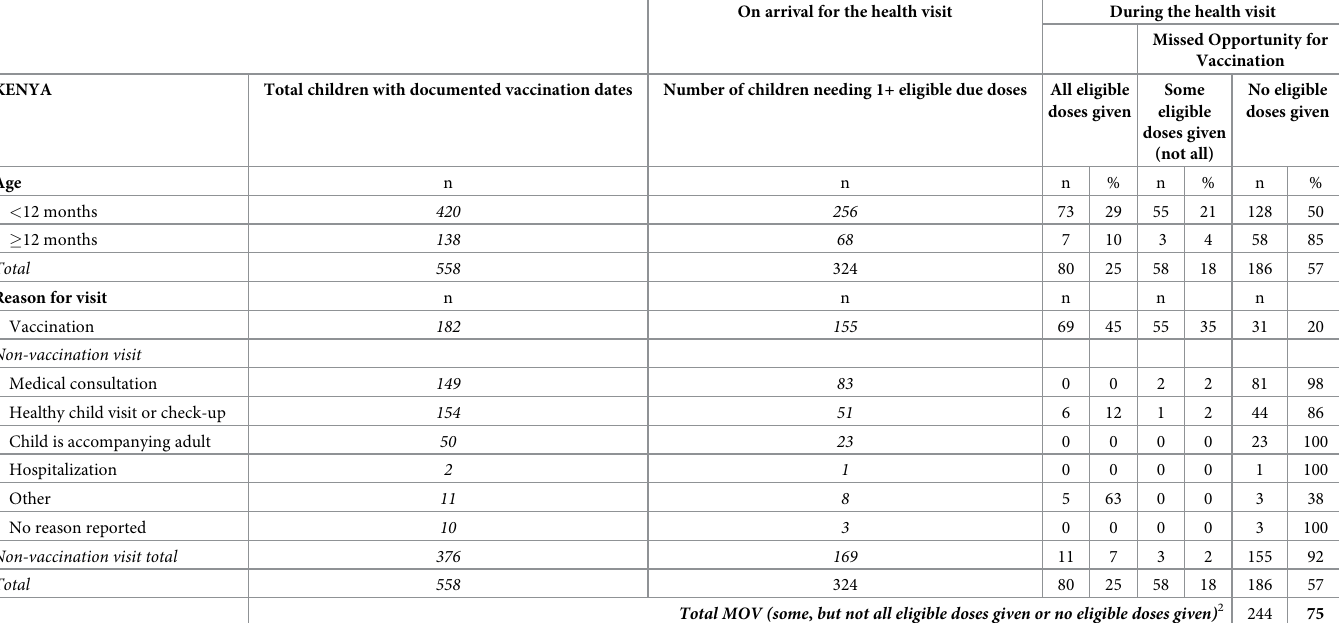
Table 3. Prevalence of missed opportunities for vaccination (MOV) 1 among surveyed children, by reason for visit and age, missed opportunities for vaccination (MOV) assessment, Kenya,